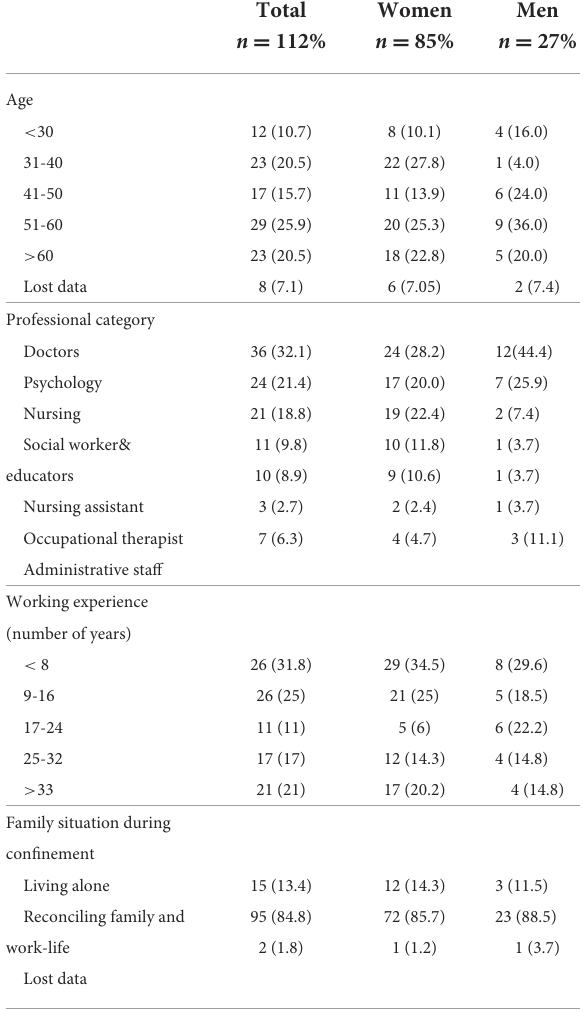
TABLE 1 Sociodemographic and professional profile among